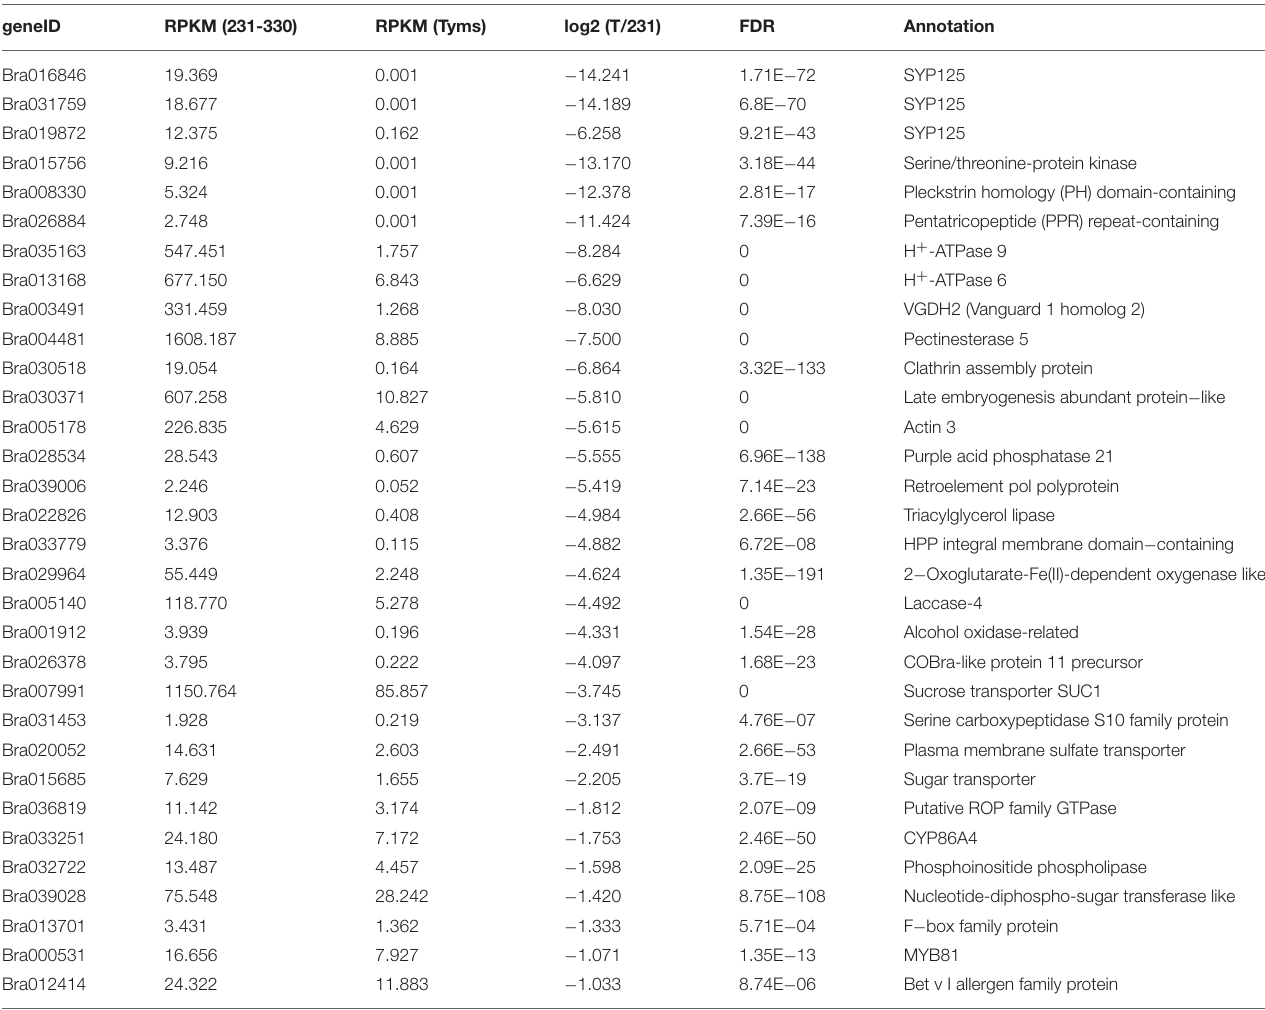
TABLE 5 | The down-regulated targets in Tyms compared to 231-330 buds.